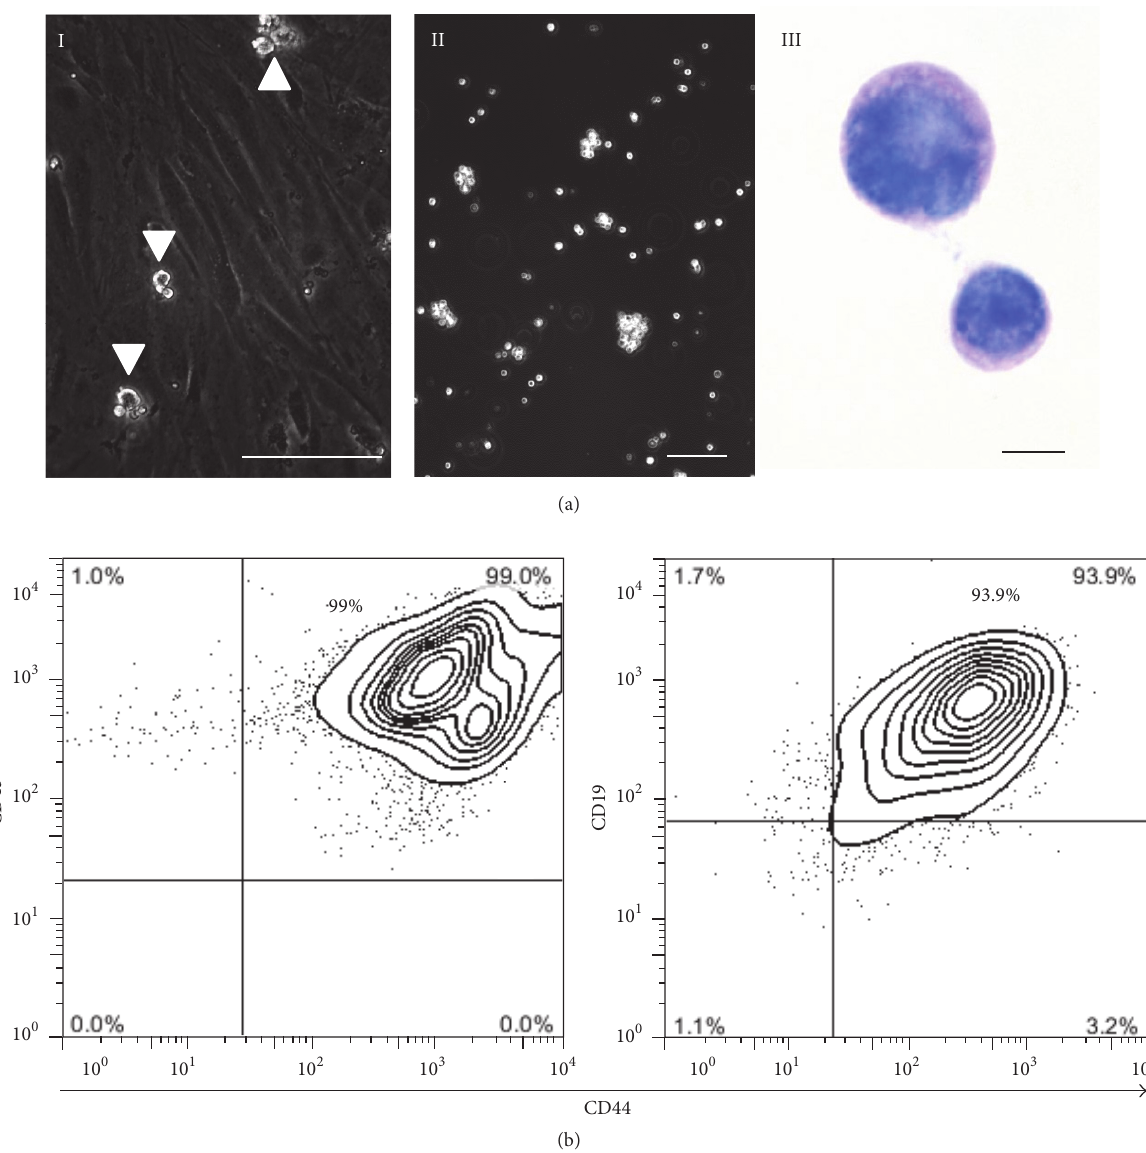
Figure 2: Characterization of subcultured myxoma cells from atrial myxoma. (a) After a period ranging from 1 to 3 weeks, phase-bright (arrow head) cells migrated over a layer of fibroblast-like cells (I, II). The phase-bright cells were collected, and Giemsa stain showed the cell with a large nucleus (III). Scale bar = 100 𝜇 m (I & II), =4 𝜇 m (III). (b) Quantification by FACS analysis of myxoma derived phase-bright cells. This cell population expresses robust CD44, CD19, and